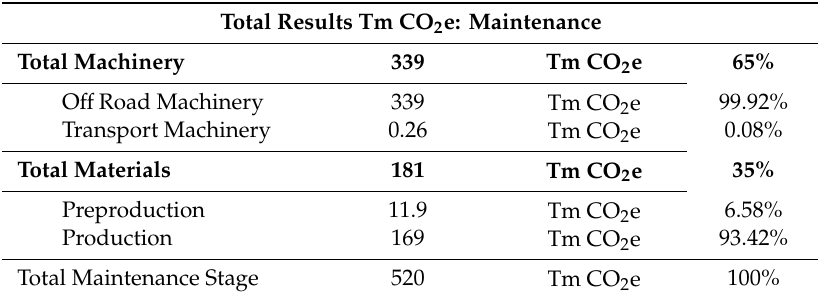
Table 6. Total CO 2 e results obtained in the maintenance